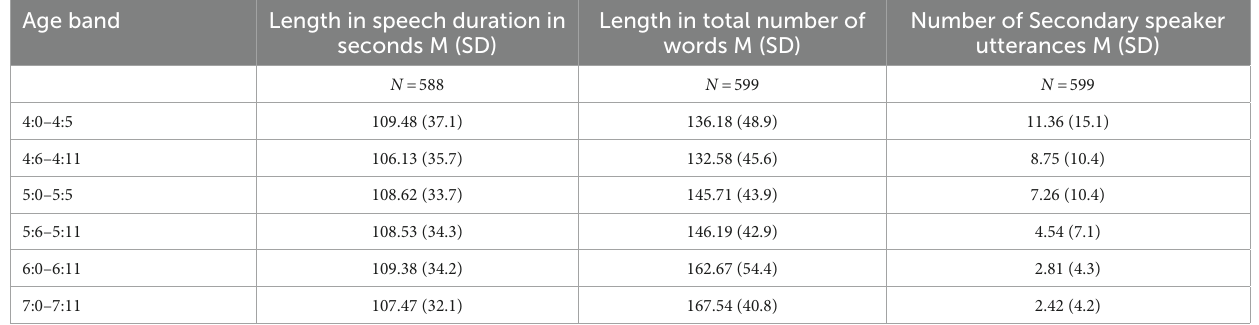
TABLE 3 Duration of speech, length in number of words and number of secondary speaker turns by age bands in the “Final 599” sample. Age band Length in speech duration in Length in total number of seconds M (SD) words M (SD)